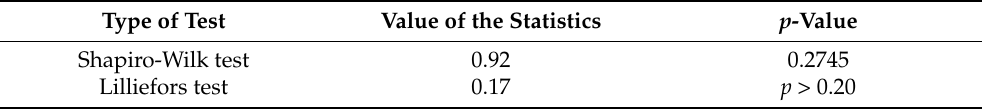
Table 5. Verification of the randomness of the ‘theta’ variable. Type of Test Value of the Statistics p -Value Wald-Wolfowitz series test for average − 0.61 0.5448 Wald-Wolfowitz series test for the median − 0.61 0.5448 Mann-Kendall test − 0.07 0.9453 Bartels rank test 0.06